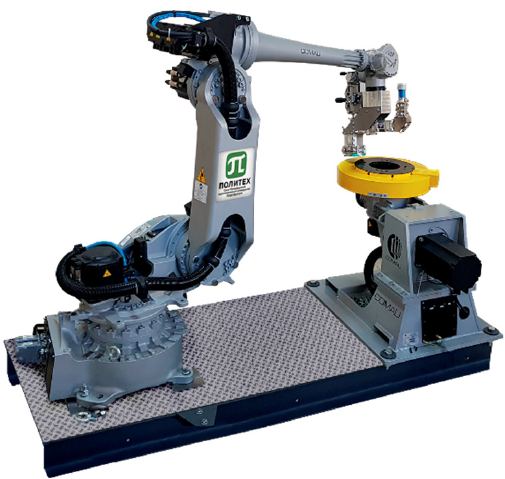
Figure 8. OKTA-Printer implementing DLD technology.